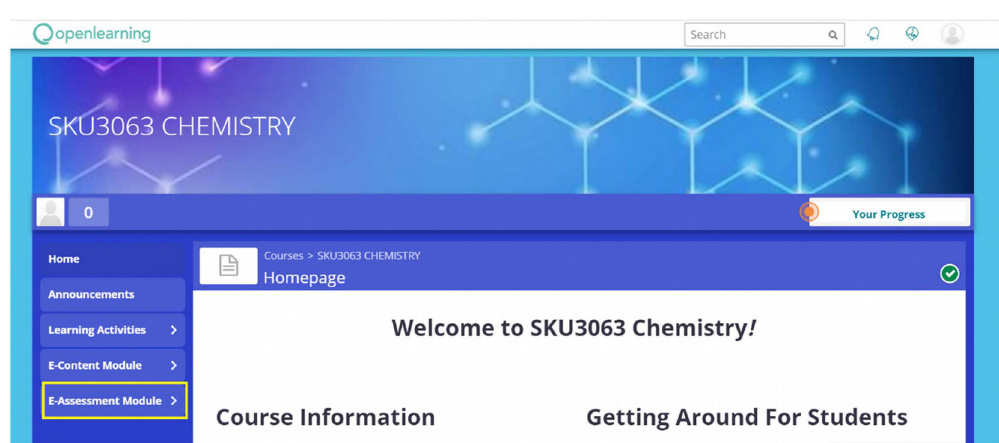
Figure 12. An e-Assessment module in Chemistry